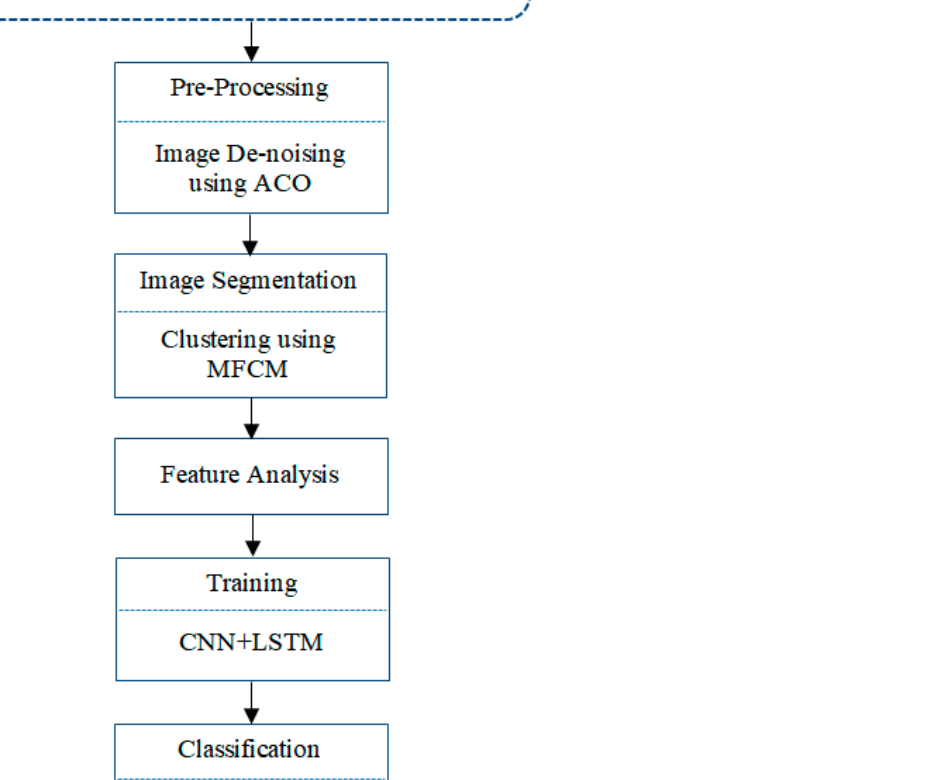
Figure 3. Sample MRI image demented categories. ( a ) Non-demented image ( b ) Very mild de- mented image ( c ) Mild demented ( d ) Moderate demented.